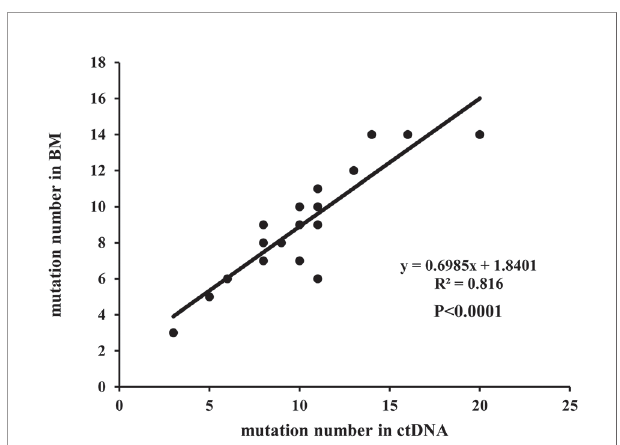
FIGURE 2 | The concordance of the number of mutation detected in BM and ctDNA.